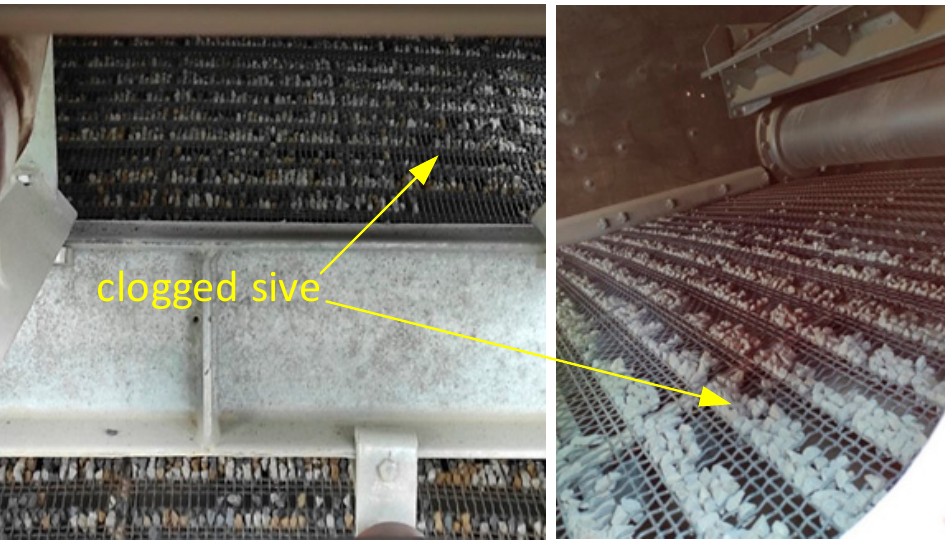
Figure 10. Difficult grains blocking slot screen decks (toss index 4.4).